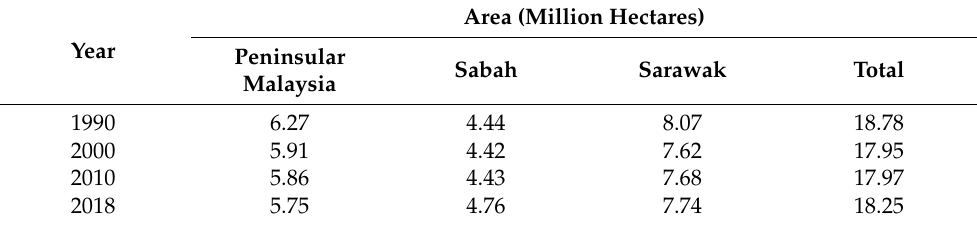
Table 1. Forest statistics collected by the Ministry of Energy and Natural Resources between 1990 and 2018 in Malaysia, by region.